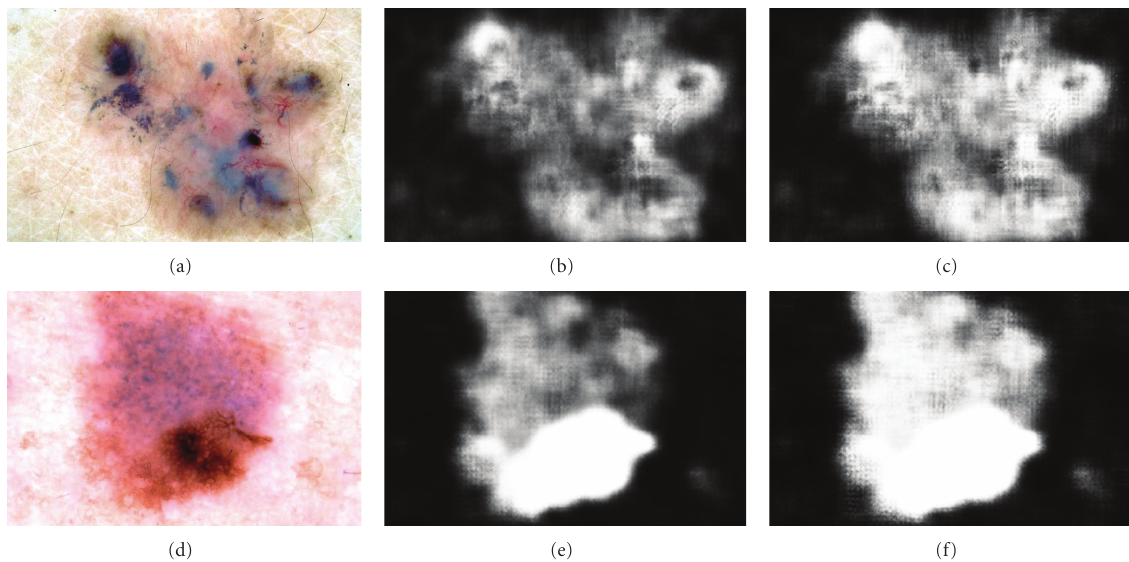
Figure 6: The e ff ect of L ∗ normalization on the segmentation likelihoods. left column: original dermoscopic image; middle: segmentation likelihoods ( L i ,lesion ) before L ∗ normalization; right: after L ∗ normalization.